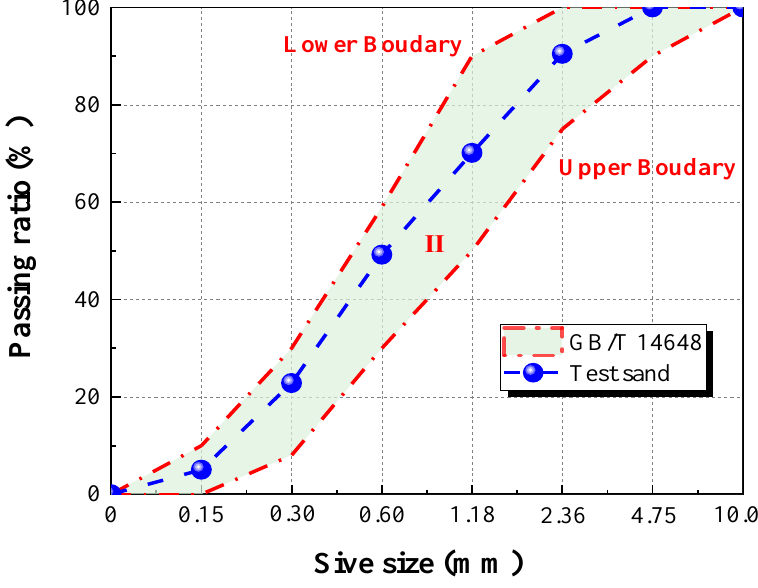
Figure 2. Gradation cure of sand.